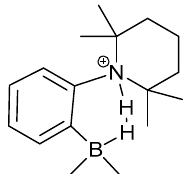
Figure 14. Structure of NHHB. The two hydrogens of the dihydrogen bond are selectively deuterated. From Ref. [39].